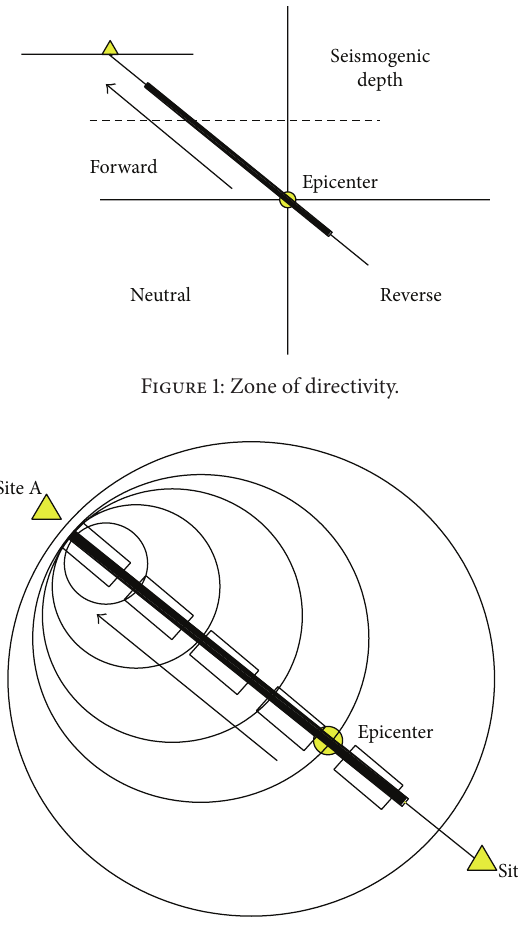
Figure 2: An example of FD effect on Site